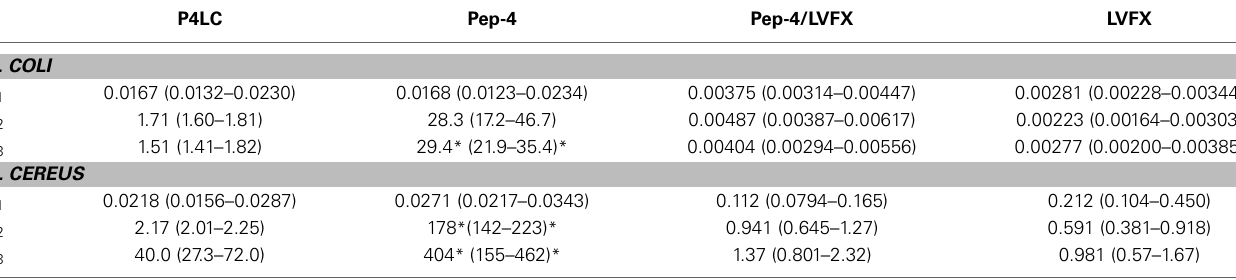
Table 1 | Antibacterial